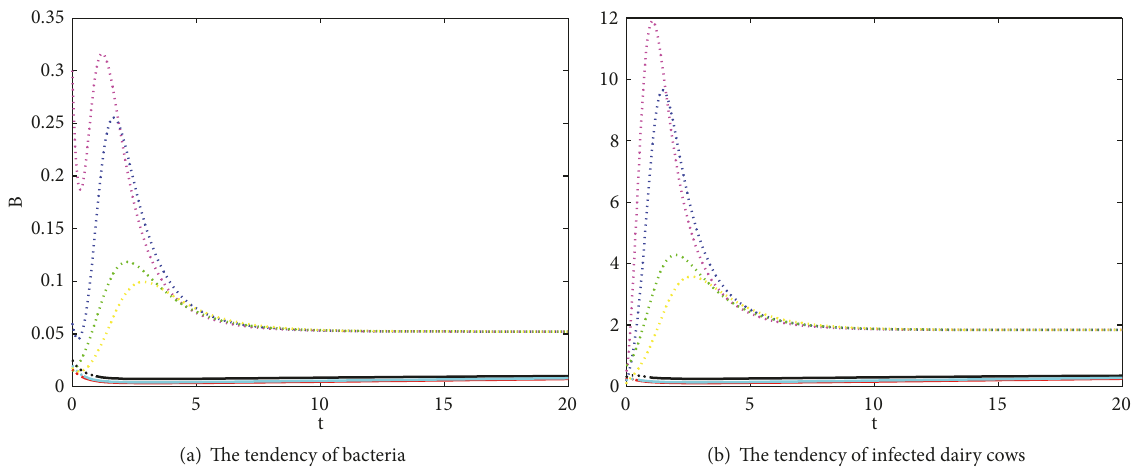
Figure 7: The common values of (a) and (b) used for the parameters are as follows: 𝑤 = 3 , 𝑑 = 2 , 𝑐 = 0.8 , 𝛿 = 4 , 𝑞 = 1 , 𝛽 = 0.2 , 𝑎 = 2 , 𝑚 = 0.05 , 𝑀 = 0.014 , and 𝐴 = 22 .